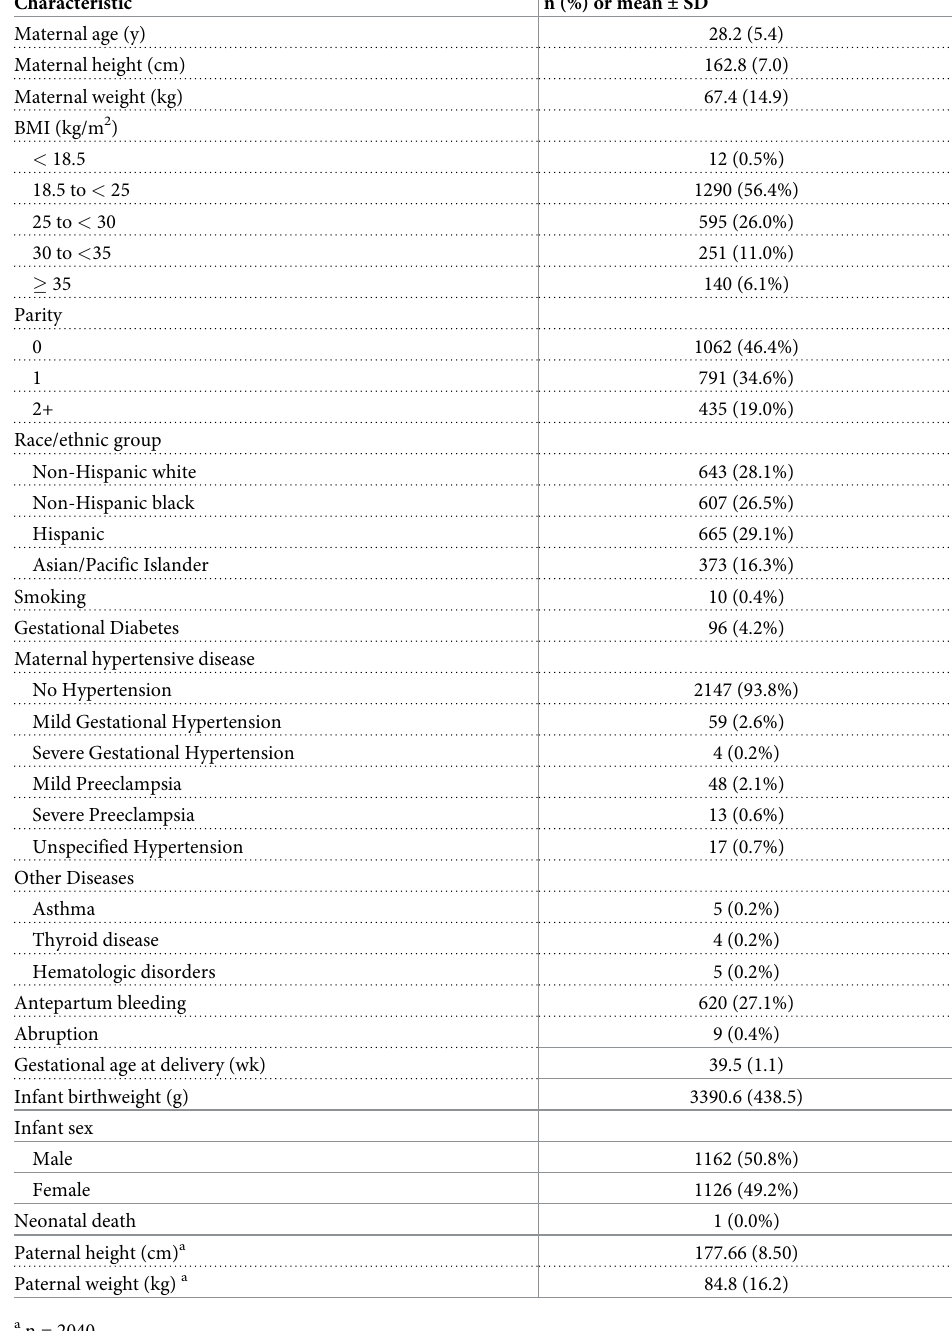
Table 1. Participant and pregnancy characteristics in the NICHD Fetal Growth Studies–Singletons (N =